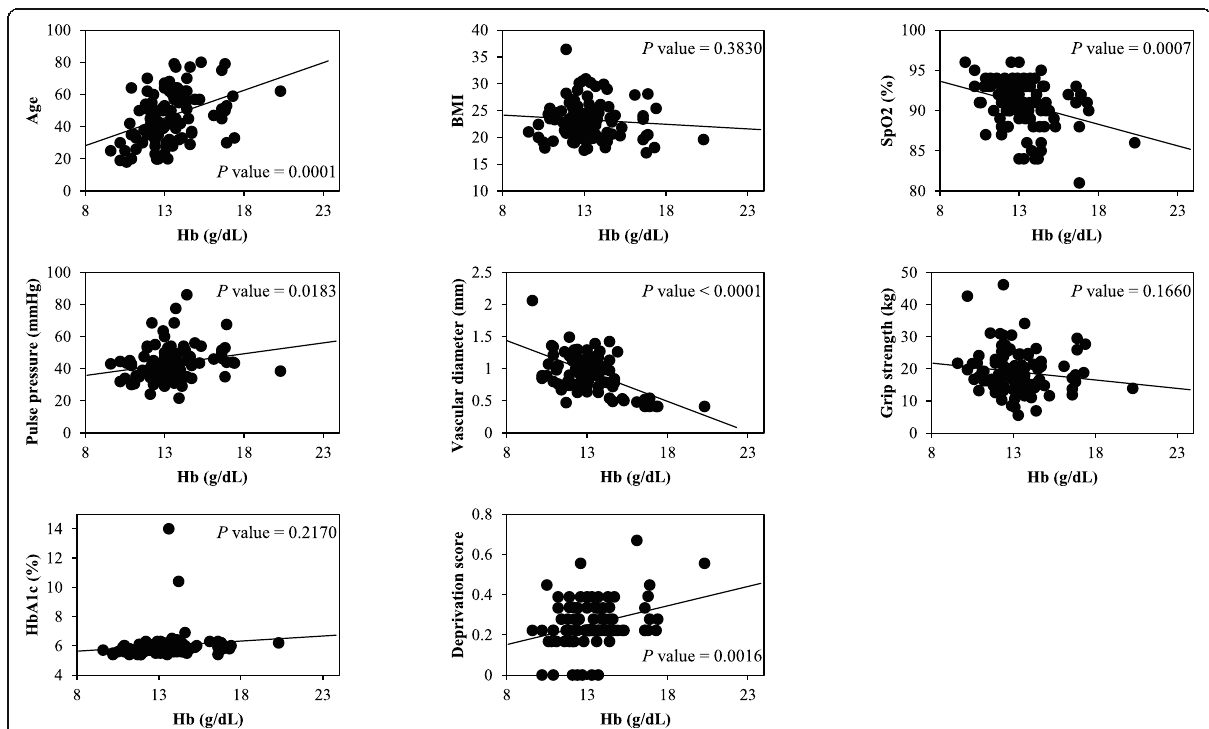
Fig. 3 Linear regression analysis of Hb and each variable in females. Each variable is plotted against the Hb concentrations of female participants. The p values indicate the results of the linear regression analysis of Hb and each variable. Age, SpO 2 , pulse pressure, vascular diameter, and deprivation score were significantly correlated with